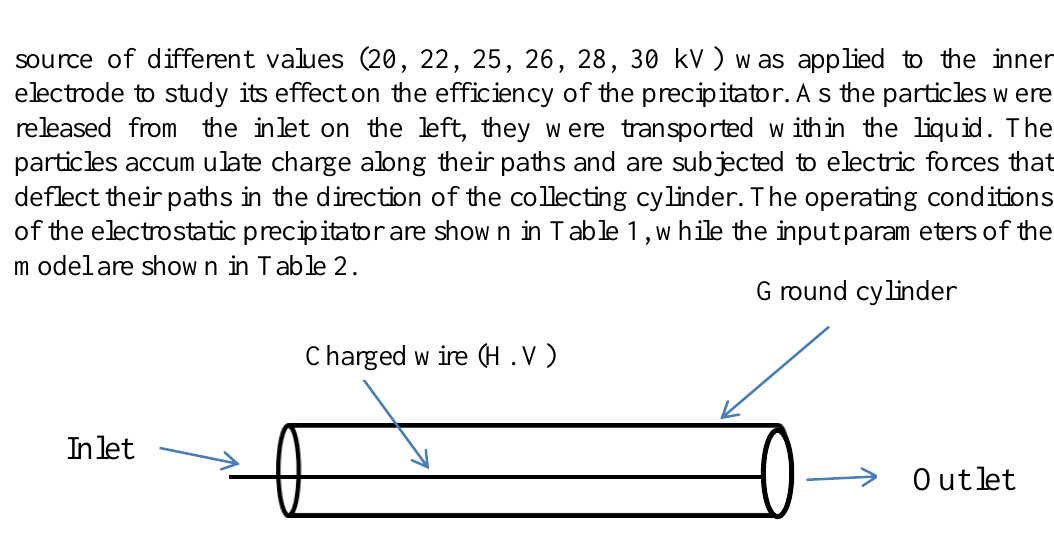
Figure 1: Schematic diagram of the Wire-cylinder electrodes geometry.